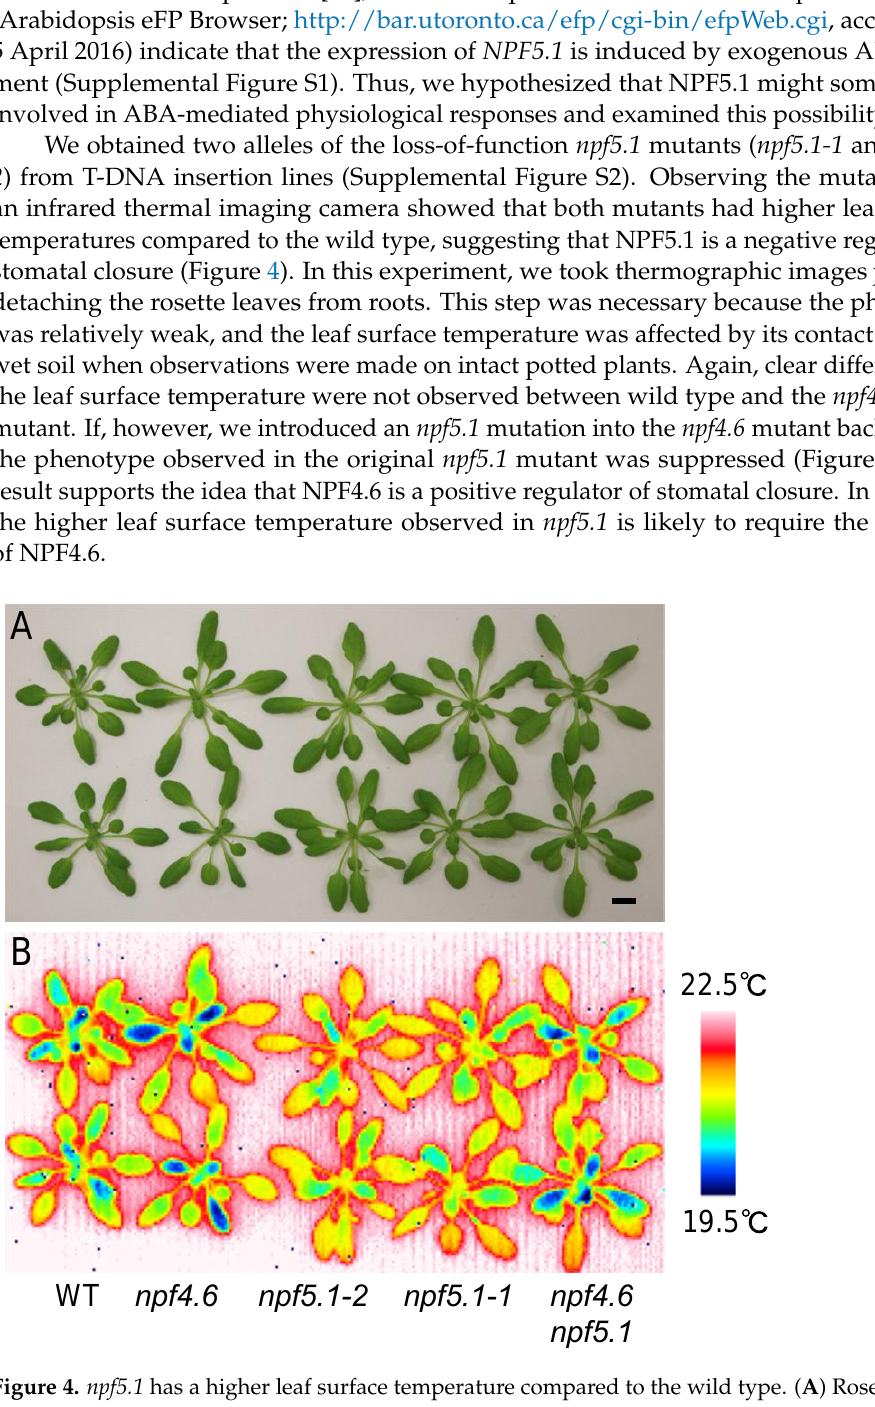
Figure 4. npf5.1 has a higher leaf surface temperature compared to the wild type. ( A ) Rosette leaves of wild type (WT), npf4.6-1 ( npf4.6 ), npf5.1-1 , npf5.1-2 and npf4.6-1 npf5.1-1 ( npf4.6 npf5.1 ) plants (approximately 1 month old) grown under a day and night (10 h light/14 h dark) cycle. Scale bar = 1 cm. ( B ) Leaf surface temperature of plants in ( A ) observed by a thermal imaging camera immediately after detachment of the rosette leaves from the roots.